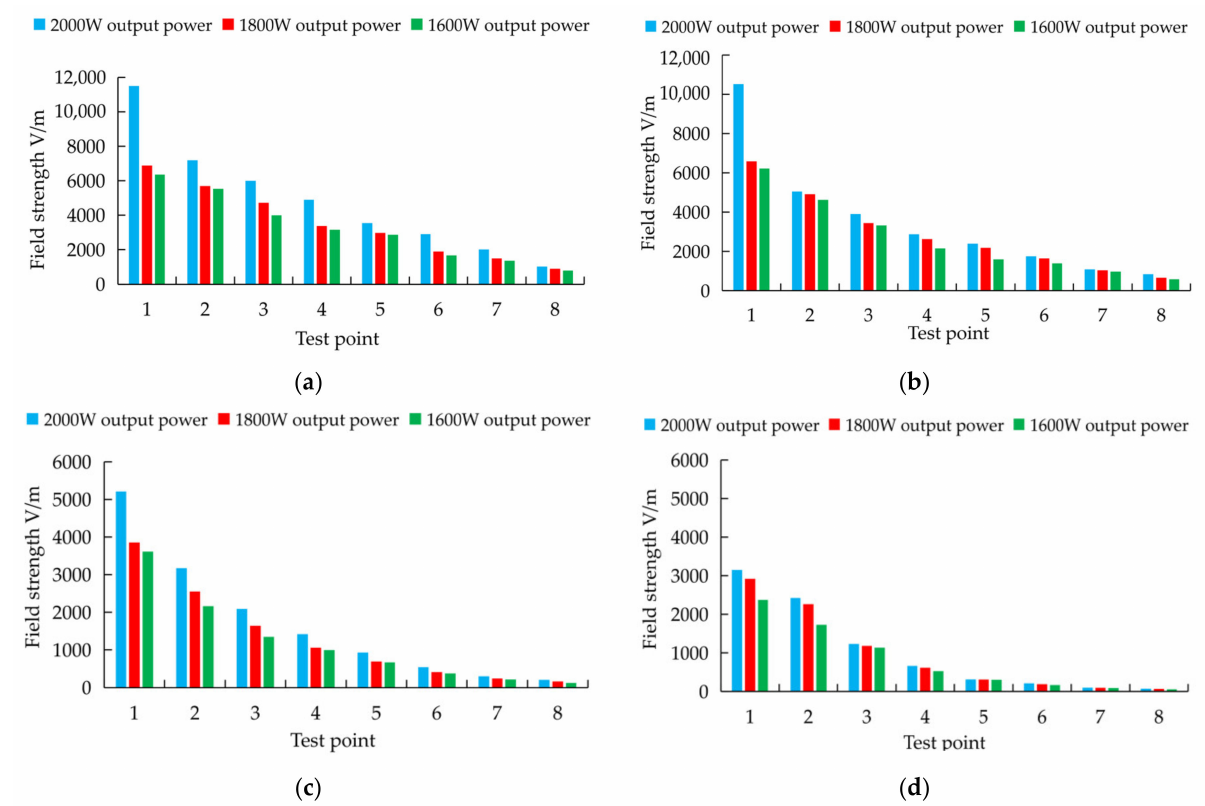
Figure 9. Field strength at each experimental point for the different soil moisture levels: ( a ) field strength at 0% soil moisture; ( b ) field strength at 10% soil moisture; ( c ) field strength at 20% soil moisture; ( d ) field strength at 30% soil